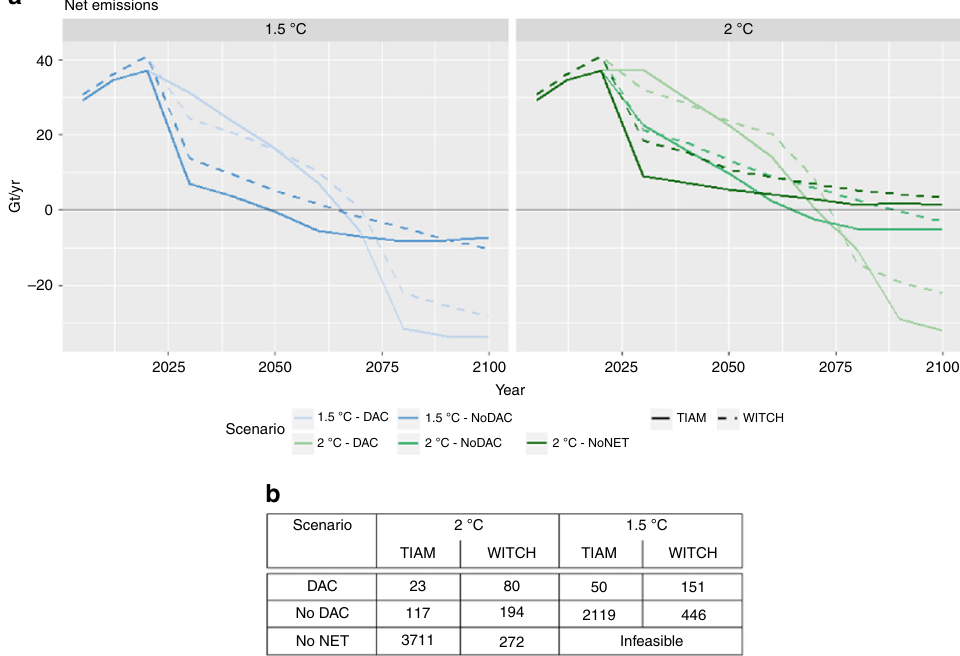
Fig. 1 CO 2 emission pathways and carbon price in 2030 in central case scenarios. CO 2 emissions ( a ) are from fossil fuel burning only, while the carbon price ( b ) is expressed in USD per ton of CO 2 Cumulative sequestration - 2 °C Cumulative sequestration - 1.5 °C